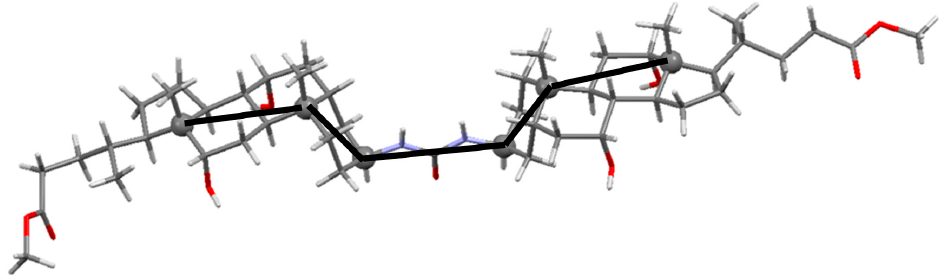
Figure 3. Perspective view of the conformer in the crystal structure of 30/AcOEt, showing its tet conformation.